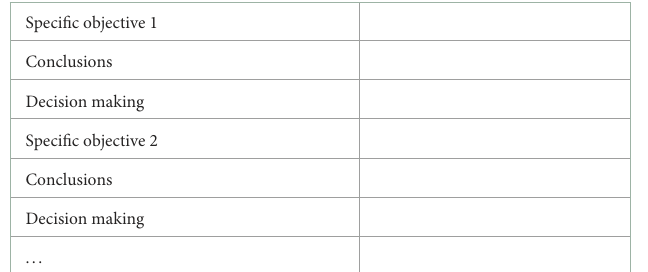
TABLE 8 Conclusions and decision